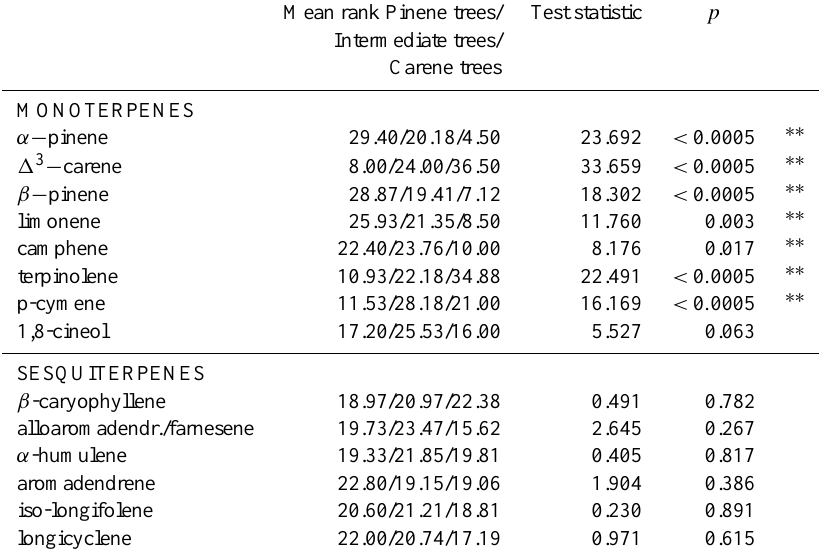
Table 2. Results of the Kruskal-Wallis -test for the proportions of emitted compounds. Statistically significant differences ( p < 0 . 05) between the clusters are marked with ∗∗ .